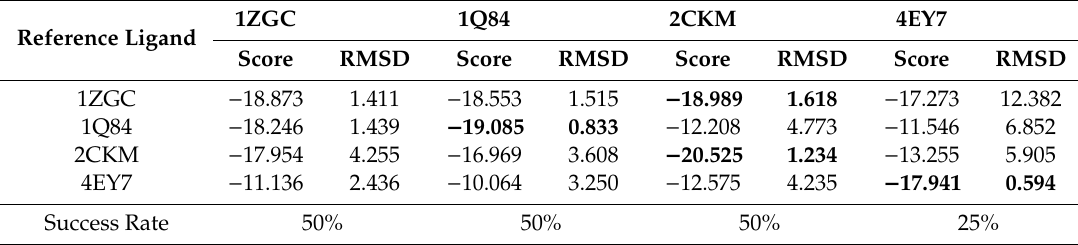
Table 5. Ensemble docking results for the reference ligands against the four AChE conformations. The binding poses selected according to the ensemble docking strategy (i.e., the AChE conformation that provides the lowest XP Score pose) are highlighted in bold, achieving 100% of success rate when considering RMSD ≤ 2.0 Å.